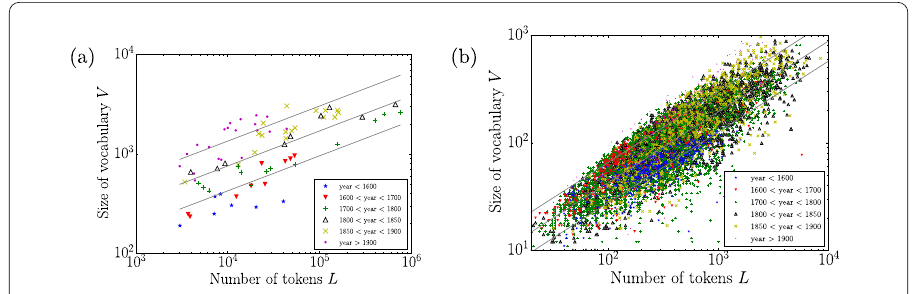
Figure 3 ( a ) Scatter plot of size of vocabulary versus number of tokens (length) for the 76 composers in the corpus, who are grouped chronologically, as represented by the points of different color (one point is one composer). The year of each composer is the mean between the birth year plus 20 and the death year. Heaps’ law is given by the central straight line and the parallel lines denote one standard deviation σ c . Notice that when a limited chronological span is considered, the scattering is reduced. ( b ) Analog scatter plot for the 9489 individual pieces. Year of a piece is approximated to the year of its composer. The results of the fits are